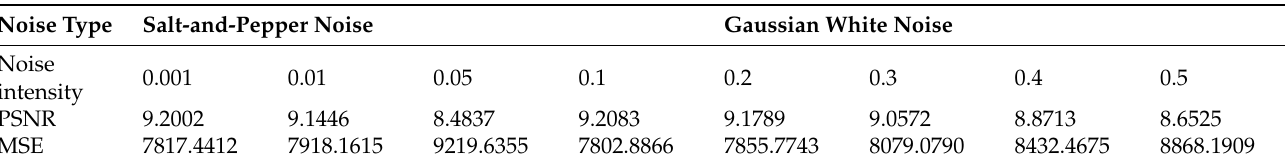
Table 8. PSNR and MES testing results under noise attacks.